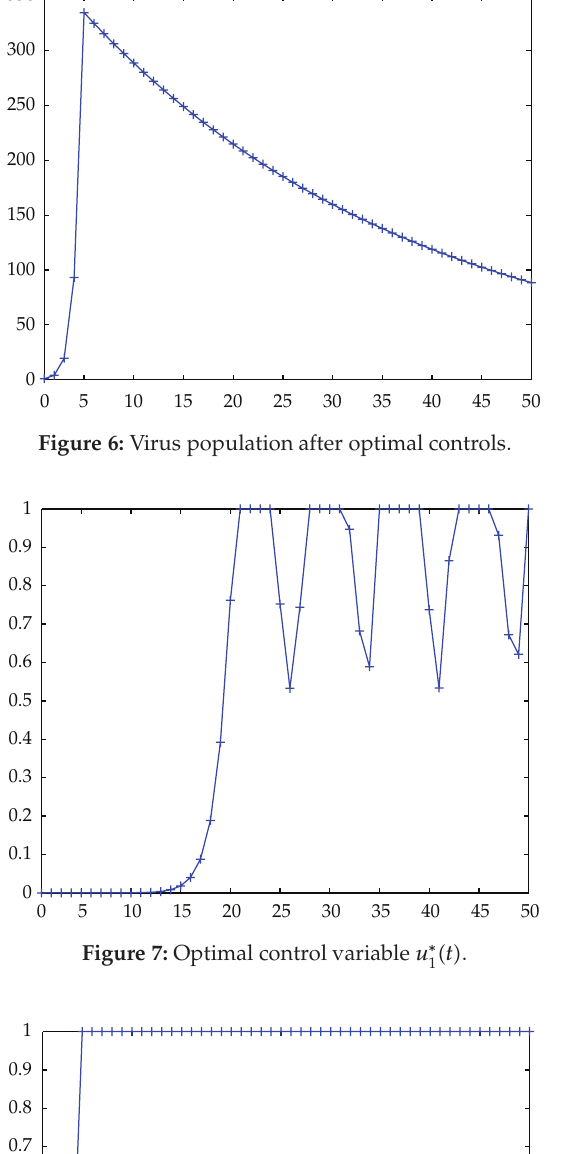
(cid:2) t (cid:3) . 1